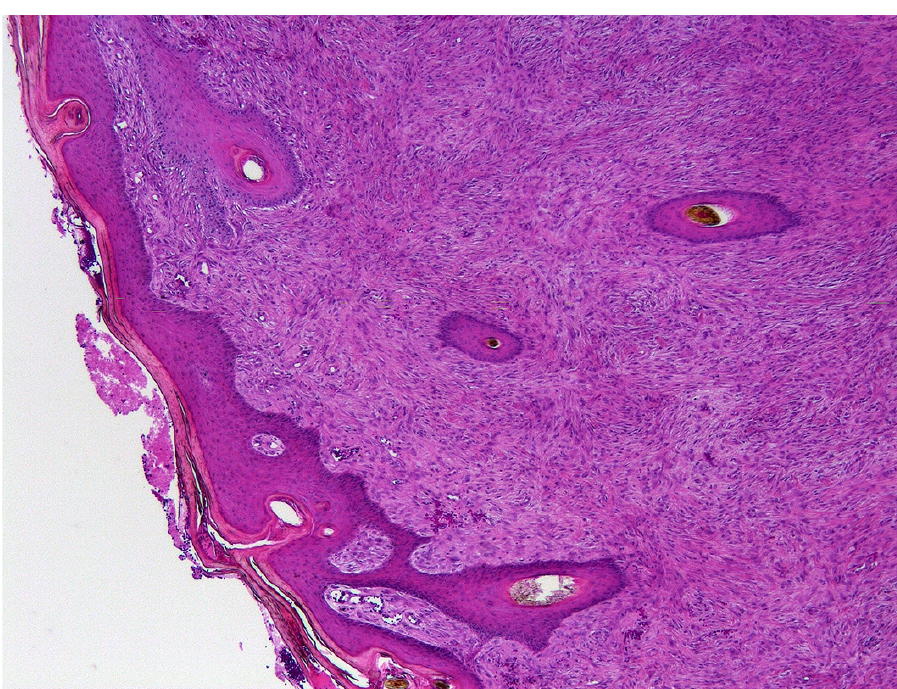
Figure 1. Photomicrograph of an equine sarcoid. Note the characteristic epidermal hyperplasia with the formation of rete pegs extending into a proliferation of mesenchymal cells arranged in tight whorls or bundles. HE 100×.